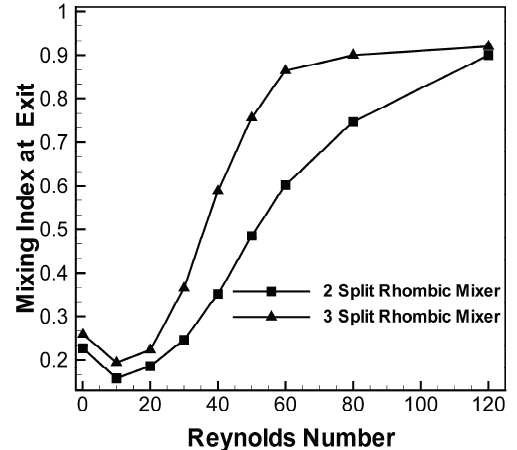
Figure 6. Variations in the mixing index at the exit of the micromixer versus Reynolds number.